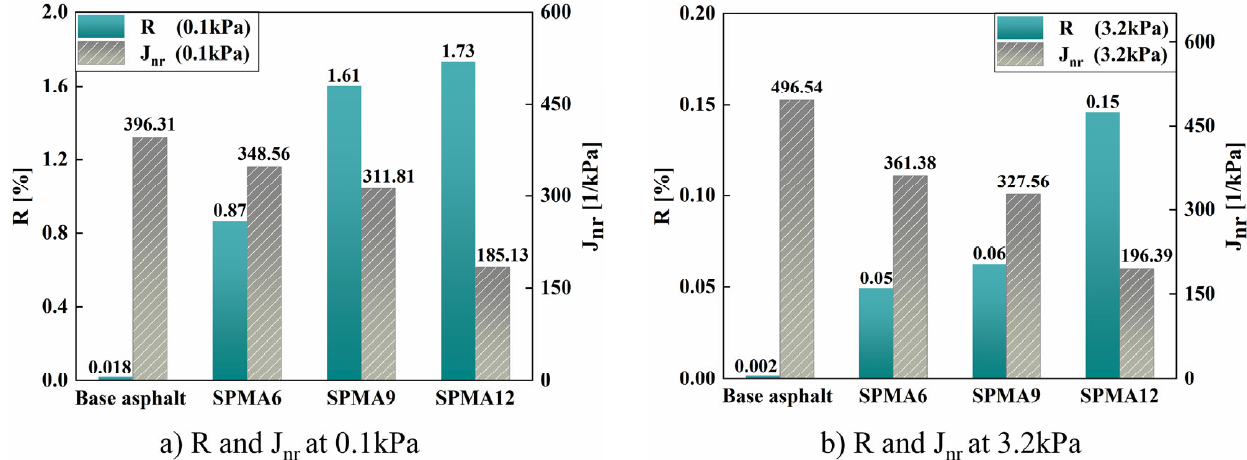
Figure 13. Calculating values of R and J nr .